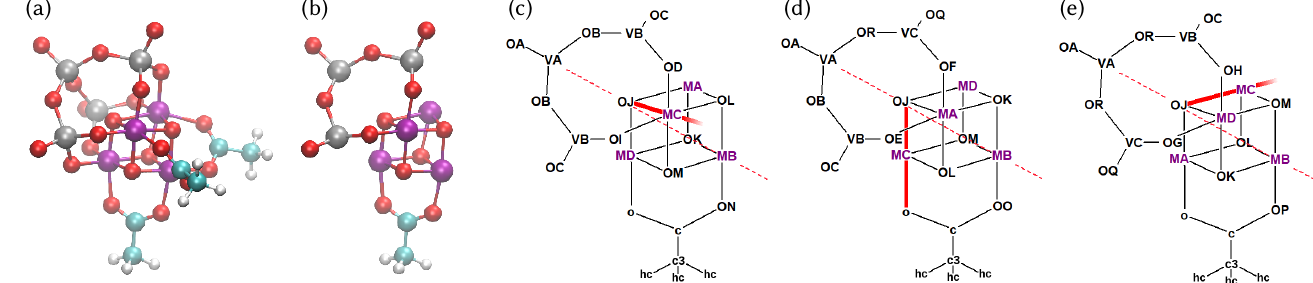
Figure 1. ( a ) 3D structure of the MnV WOC featuring the three symmetry equivalent acetate ligands (bottom, right, and front) and the tripodal [V 4 O 13 ] ligand (left, top, and back). ( b ) Simplified version of the structure of the MnV WOC, in which only the full [Mn 4 O 4 ] cubane core, one acetate ligand, and a portion of the [V 4 O 13 ] ligand are shown to avoid occlusion. To define the FF parameters, each atom is assigned an “atom type label”, such that atoms with the same label will use the same FF parameters but atoms with different labels can be assigned independent parameters. The assignment of atom types is shown in panels ( c – e ), where each panel shows a different subset of the entire connectivity network to avoid occlusion. The three panels are related by a 120 or 240 degree rotation of the entire molecule, before occluded atoms are removed. See the text for further discussion of the atom type labeling. The Jahn–Teller axis OJ–MC–o present in [Mn III Mn IV a red bold line in panels ( c – e